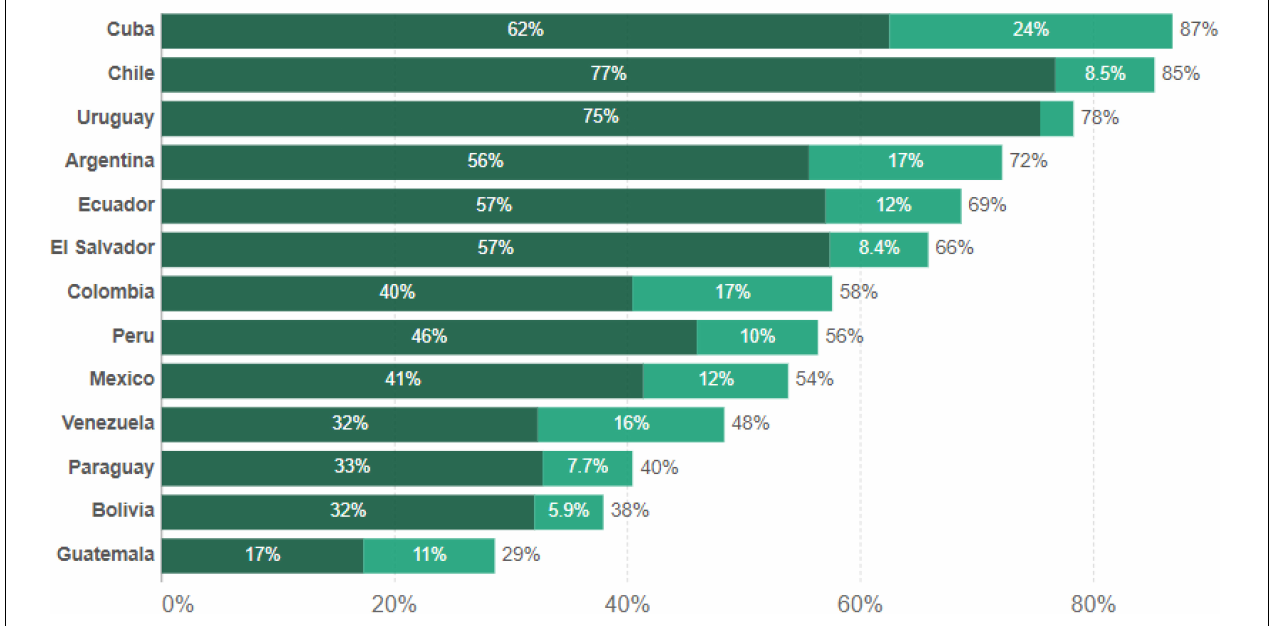
FIGURE 2 | Percentage of people vaccinated against COVID-19 by October 25, 2021 in participating countries based on data derived from Our World in Data (2021);